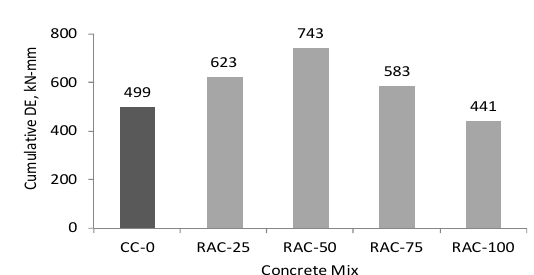
Fig.16: Cumulative dissipated energy in ten cycles of 6mm